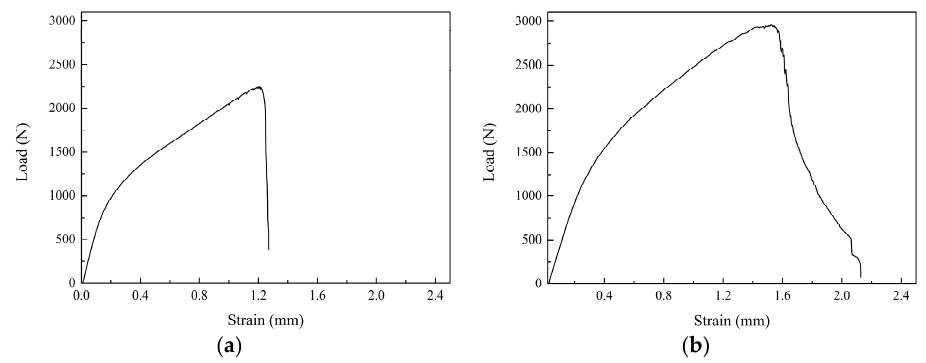
Figure 8. Load-strain curves of the failed tensile shear test specimens: ( a ) failed across the faying surface; ( b ) failed in the weld of the skin.